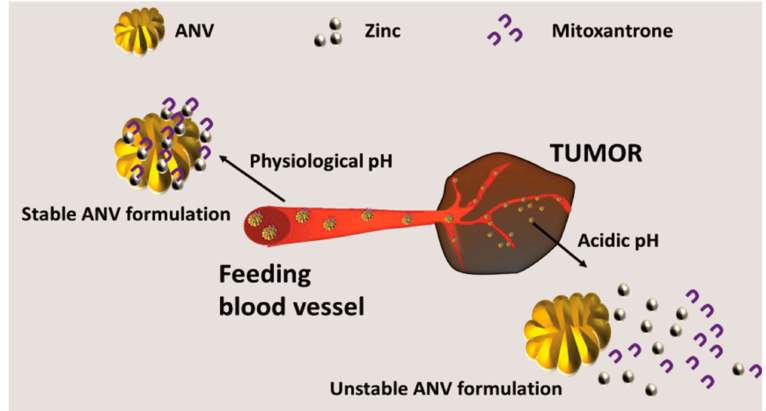
Figure 5. Generation of smart environmentally responsive ANVs, namely: pH-responsive ANVs were generated via the classical denaturation protocols. The system was doped with zinc to generate coordination bonds between the ANVs and the therapeutic mitoxantrone. This bond is stable at a physiologic pH, but at the acidic pH of the tumor microenvironment, it results in being unstable, allowing for the release of the